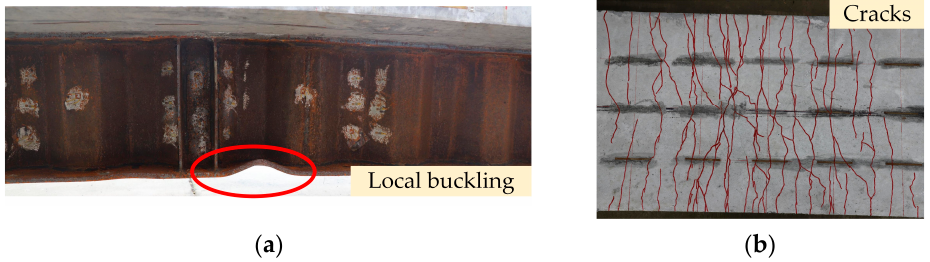
Figure 5. Failure modes: ( a ) local buckling of the bottom flange; ( b ) cracking of the ECC